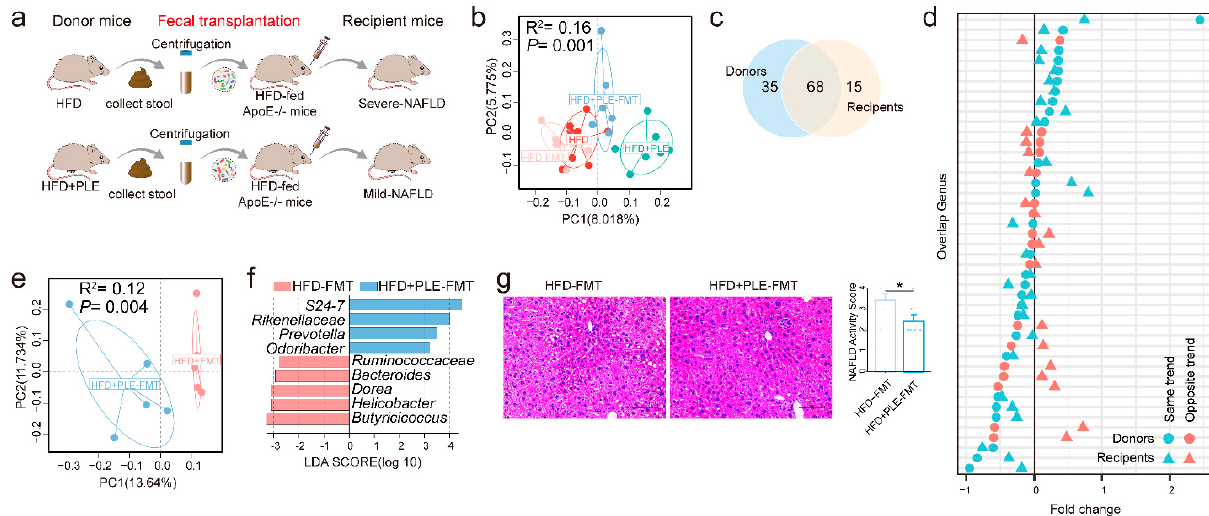
Figure 4. FMT from PLE-treated donor mice prevented HFD-induced NAFLD in recipient mice. ( a ) Study design of the fecal transplantation experiment. ( b ) Principal coordinate analysis (PCoA) plots of donors and recipient mice based on unweighted UniFrac distance matrices (n = 6). ( c ) Venn diagram comparing the numbers of shared genera in the gut microbiome of donors and recipient mice (n = 6). ( d ) Concordance of genus variations between the intestinal microbiota of donors and recipient mice. ( e ) PCoA plots of the HFD-FMT and HFD+PLE-FMT groups based on unweighted UniFrac distance matrices. ( f ) Linear discriminant analysis effect size (LEfSe) analysis identified different taxa between the HFD-FMT and HFD+PLE-FMT groups (n = 6). The LDA scores (log10) > 2.0 are listed. ( g ) Representative H&E images of liver and NAFLD activity scores of the HFD-FMT and HFD+PLE-FMT groups (n = 7). p values were calculated using the Wilcoxon rank-sum test and corrected using the method described by Benjamini and Hochberg, * p < 0.05 indicate a significant difference between the two corresponding groups. HFD-FMT: fecal microbiota transplantation from mice in the HFD group and treatment with a high-fat diet; HFD+PLE-FMT: fecal microbiota transplantation from mice in the HFD+PLE group and treatment with a high-fat diet.